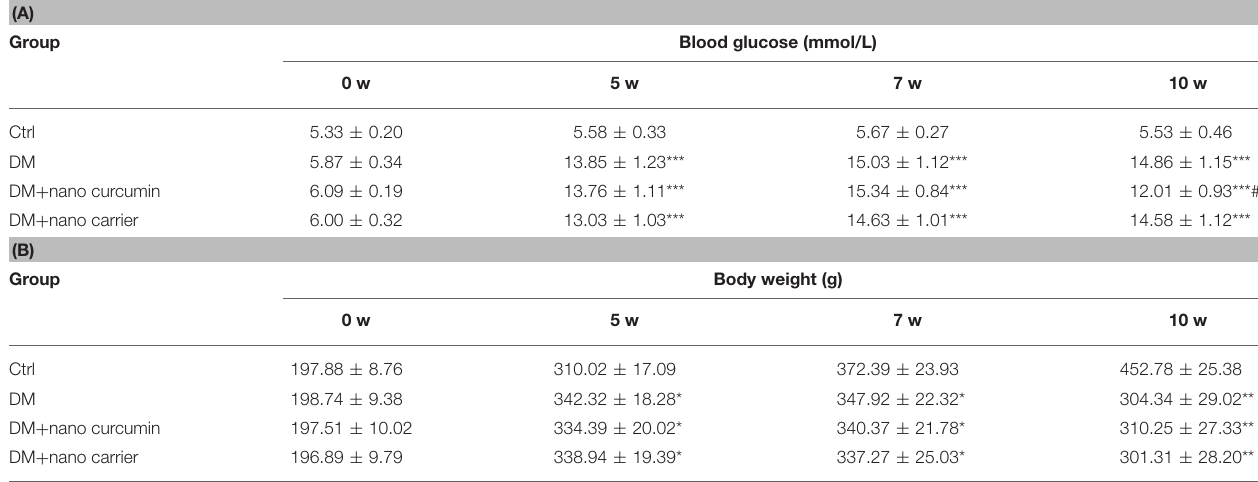
TABLE 1 | (A) Effect of the nano curcumin on blood glucose levels in type 2 diabetic rats. (B) Effects of nano curcumin on body weight (g) in type 2 diabetic rats. (A) Group